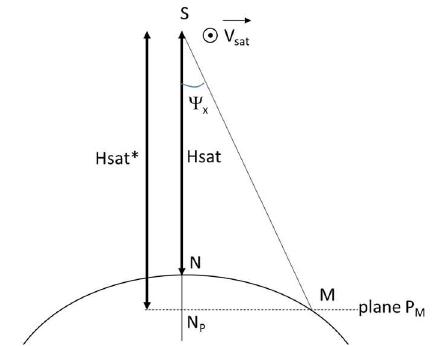
Figure 6 : Definition of N, N P , H sat , H sat *, and Y x angle.